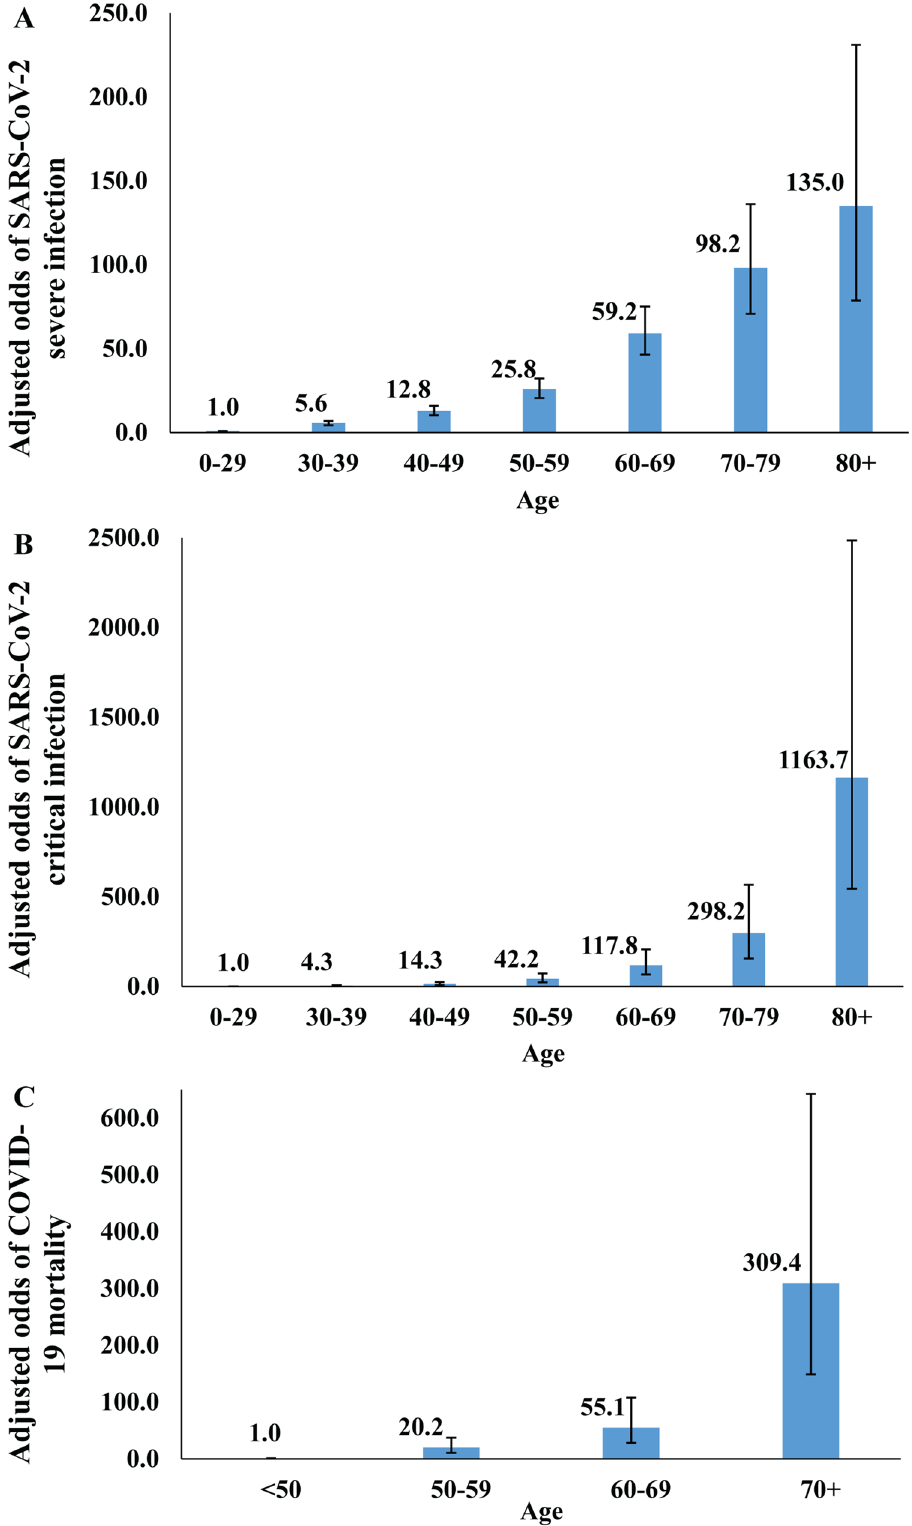
Figure 2. Association of age with ( A ) SARS-CoV-2 severe infection, ( B ) SARS-CoV-2 critical infection, and ( C ) COVID-19 death, adjusted for sex, nationality, and time of PCR testing. Severe infections, critical infections, and COVID-19 deaths were defined based on the World Health Organization criteria for classifying SARS- CoV-2 infection severity 10 and COVID-19-related death 3